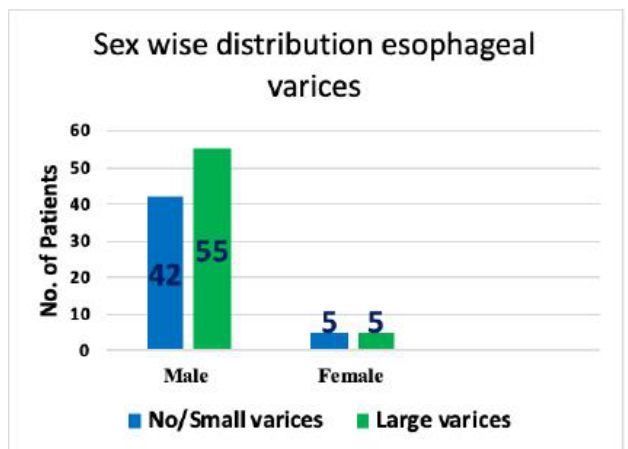
Fig 2. Upper GI Endoscopy